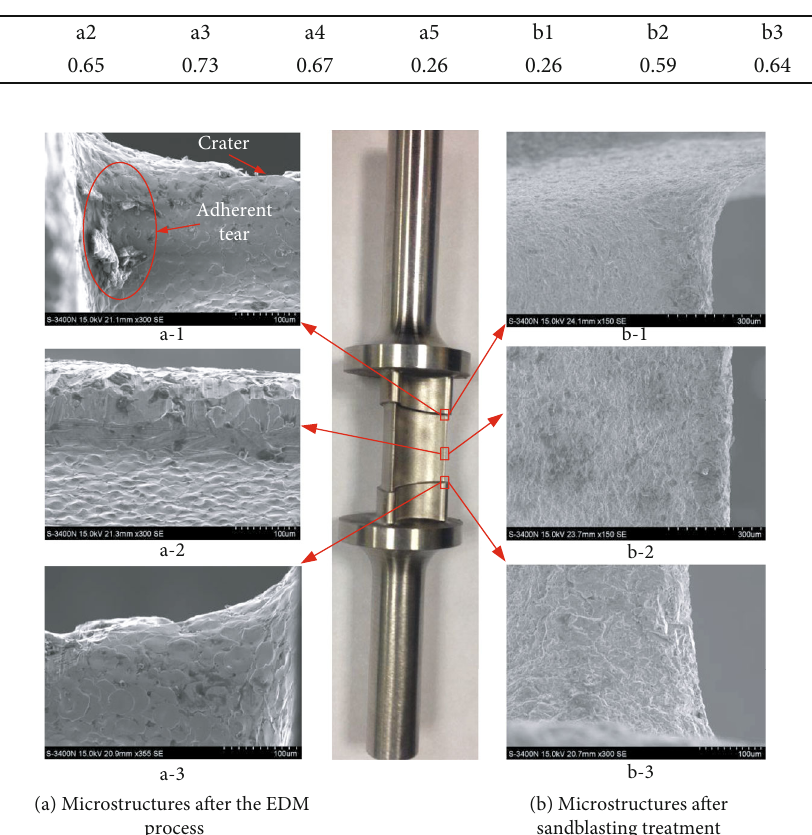
Figure 13: Microstructures on the surface of the blade specimen. (a) Microstructures after the EDM process. (b) Microstructures after sandblasting